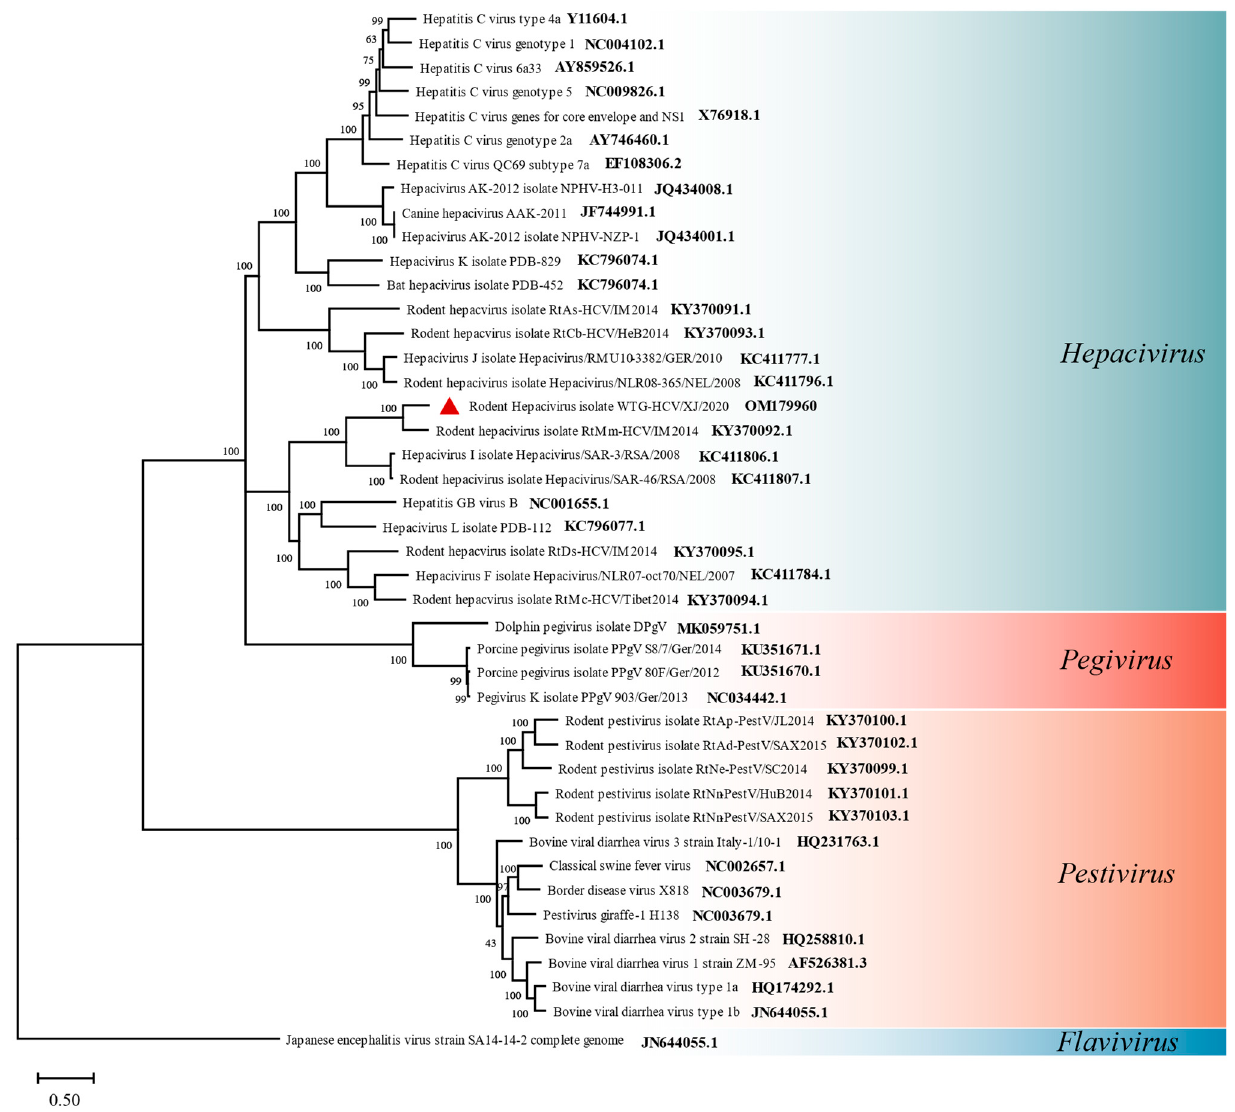
Figure 5. Phylogenetic relationship based on 8772 bp long partial polyprotein region (217–8988 bp on polyprotein of rodent Hepacivirus isolate RtMm-HCV/IM2014 polyprotein gene, acc.no.KY370092) of Hepacivirus and other members of Flaviviridae from rodent and other hosts. The analysis was inferred using the maximum likelihood method based on MEGA X. GenBank accession numbers are indicated at the branches of the tree, if available. Branch bootstrap values are shown and were based on 1000 bootstrap simulations. The contig of rodent Hepacivirus from gerbils is marked with a red triangle. The scale bar depicts an evolutionary distance of 0.50.